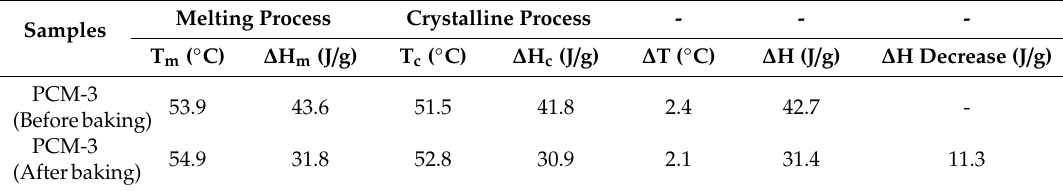
Figure 8. ( a ) Thermal stability analysis of SR, PW, EG / PW and PCM-3, ( b ) XRD spectra and ( c ) DSC Figure 8. .( a ) Thermal stability analysis of SR, PW, EG/PW and PCM-3, ( b ) XRD spectra and ( c ) DSC curves spectra of PCM-3 before and after (150 ◦ C, 24 h) baking and ( d ) DSC curves of PCM-3 (after curves spectra of PCM-3 before and after (150 °C, 24 h) baking and ( d ) DSC curves of PCM-3 (after − M × 100%, where M t baking) with in 20 cycles. Weight loss = M 0 × 100% , where M 0 is the initial mass of samples and M t baking) with in 20 cycles. Weight loss = M 0 −M t 0 is the initial mass of samples and M t M t M t is the mass of samples weighted at specific time. is the mass of samples weighted at specific time. Table 2. Thermal characteristics of PCM-3 before and after Table 2. Thermal characteristics of PCM-3 before and after baking.